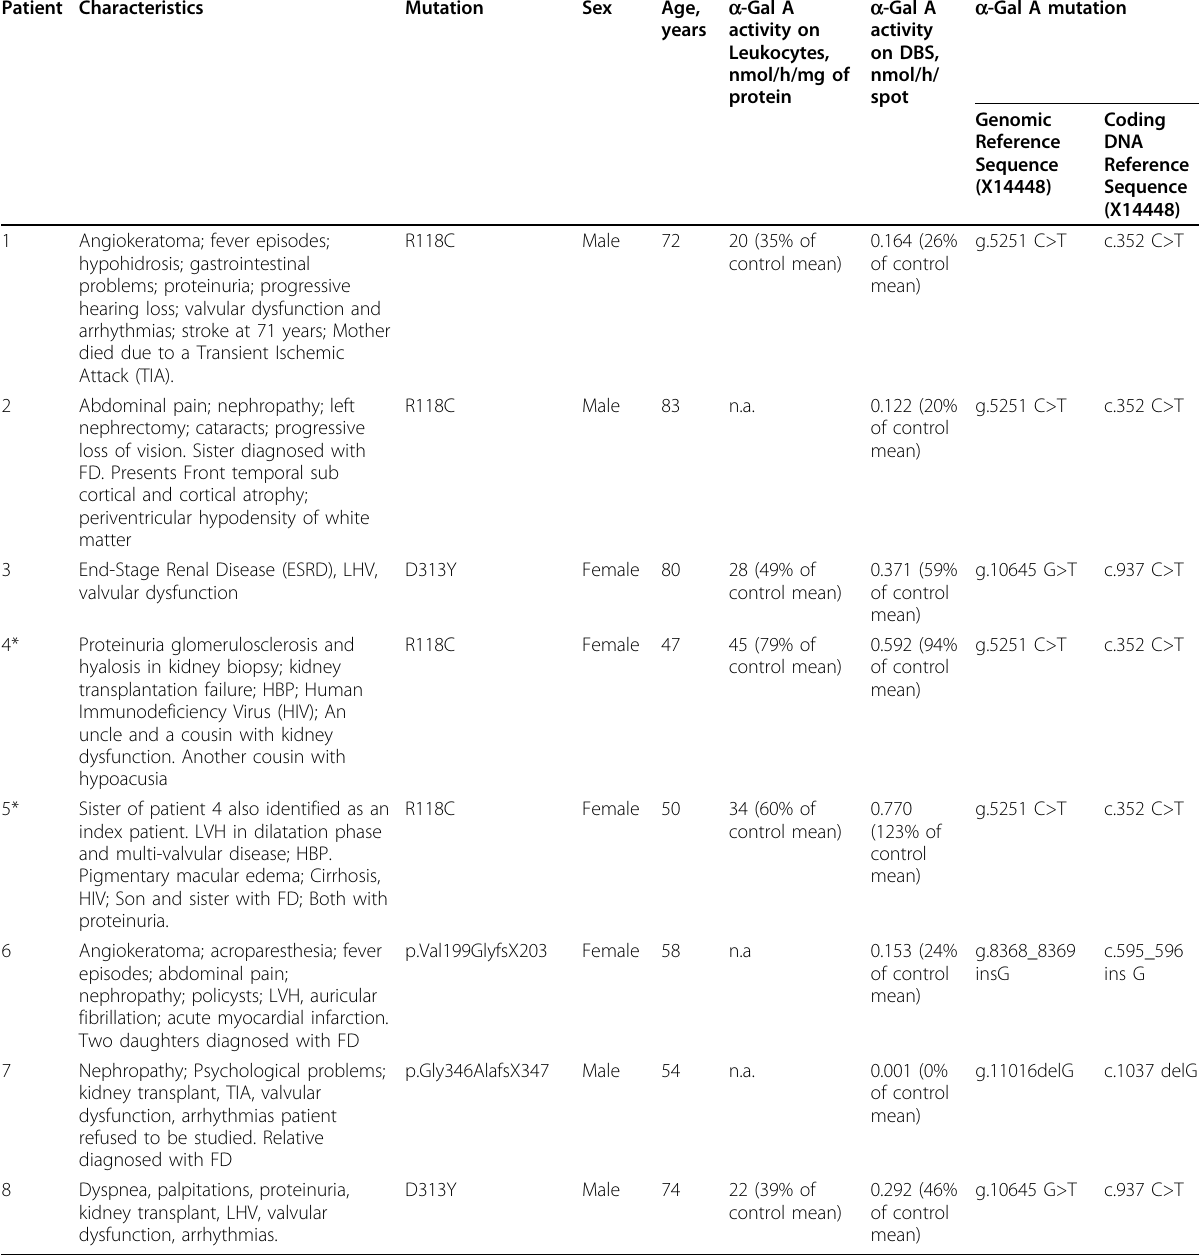
Table 1 Characteristics of patients identified in the screening Patient